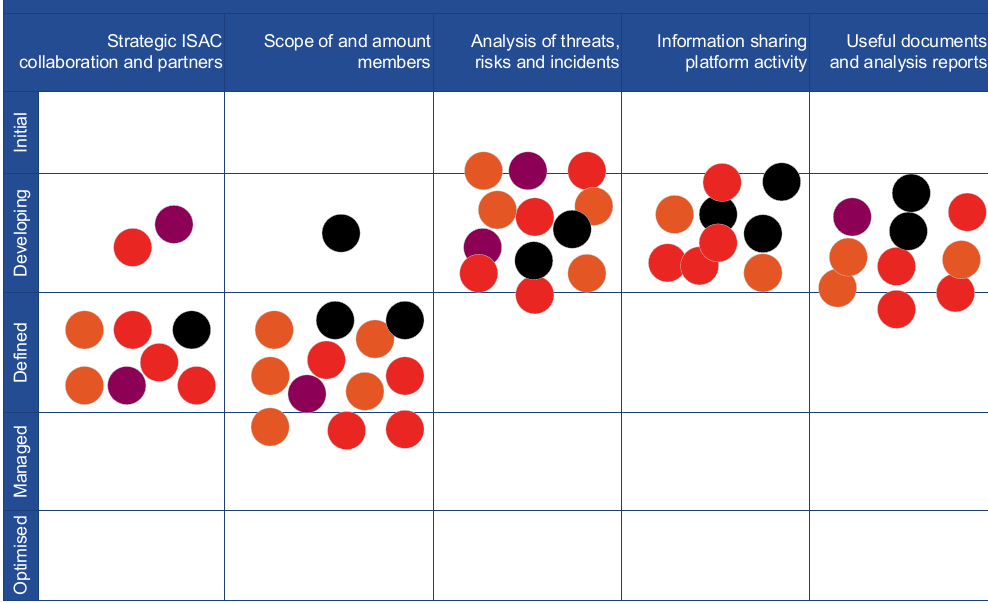
Figure 1. Progress of EE-ISAC development.